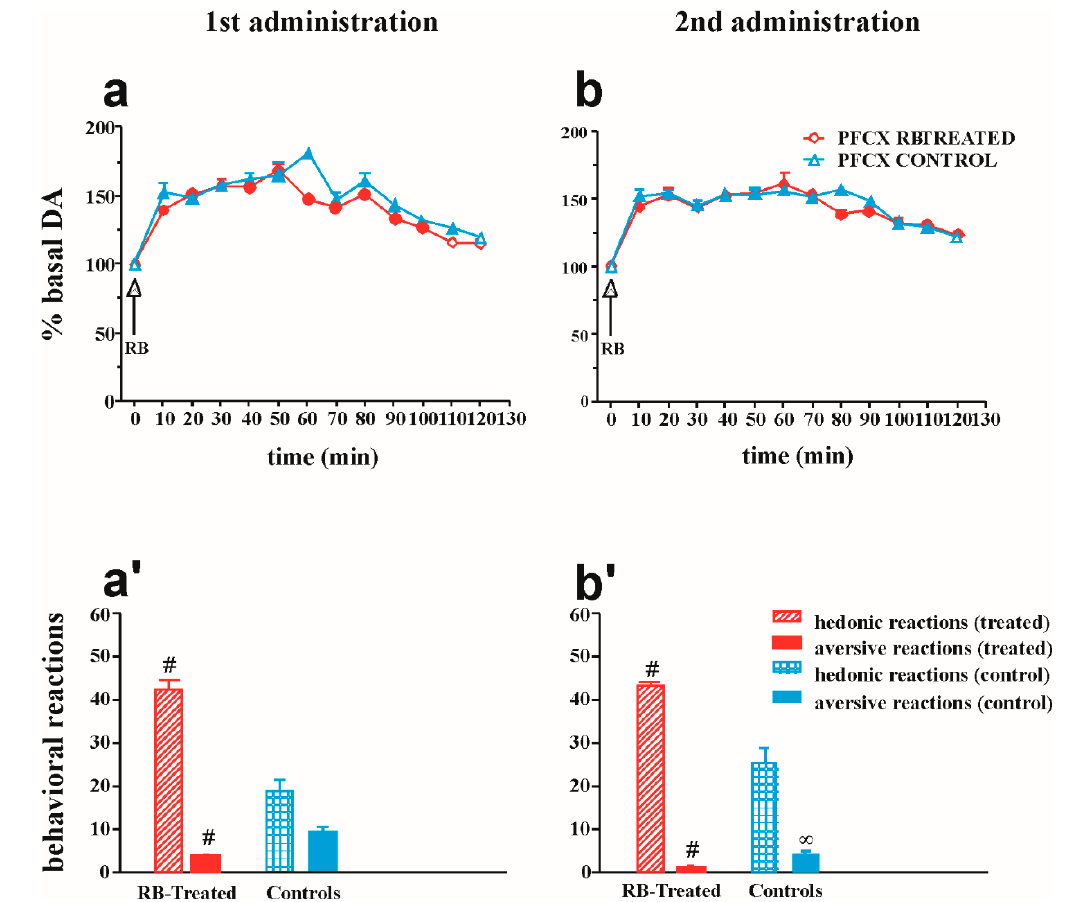
Figure 5. mPFCX DA responsiveness and taste reactions after repeated intraoral RB administration in RB-treated and control animals. Figure 5 also shows the score of hedonic and aversive taste reactions during intraoral RB infusion. ( a , b ) DA transmission: filled symbols p < 0.001 vs. basal value. ( a’ , b’ ). Statistical analysis: three-way ANOVA. Taste reactions: # p < 0.001 vs. control rats, ∞ p < 0.001 vs. first administration. Statistical analysis: two-way ANOVA.